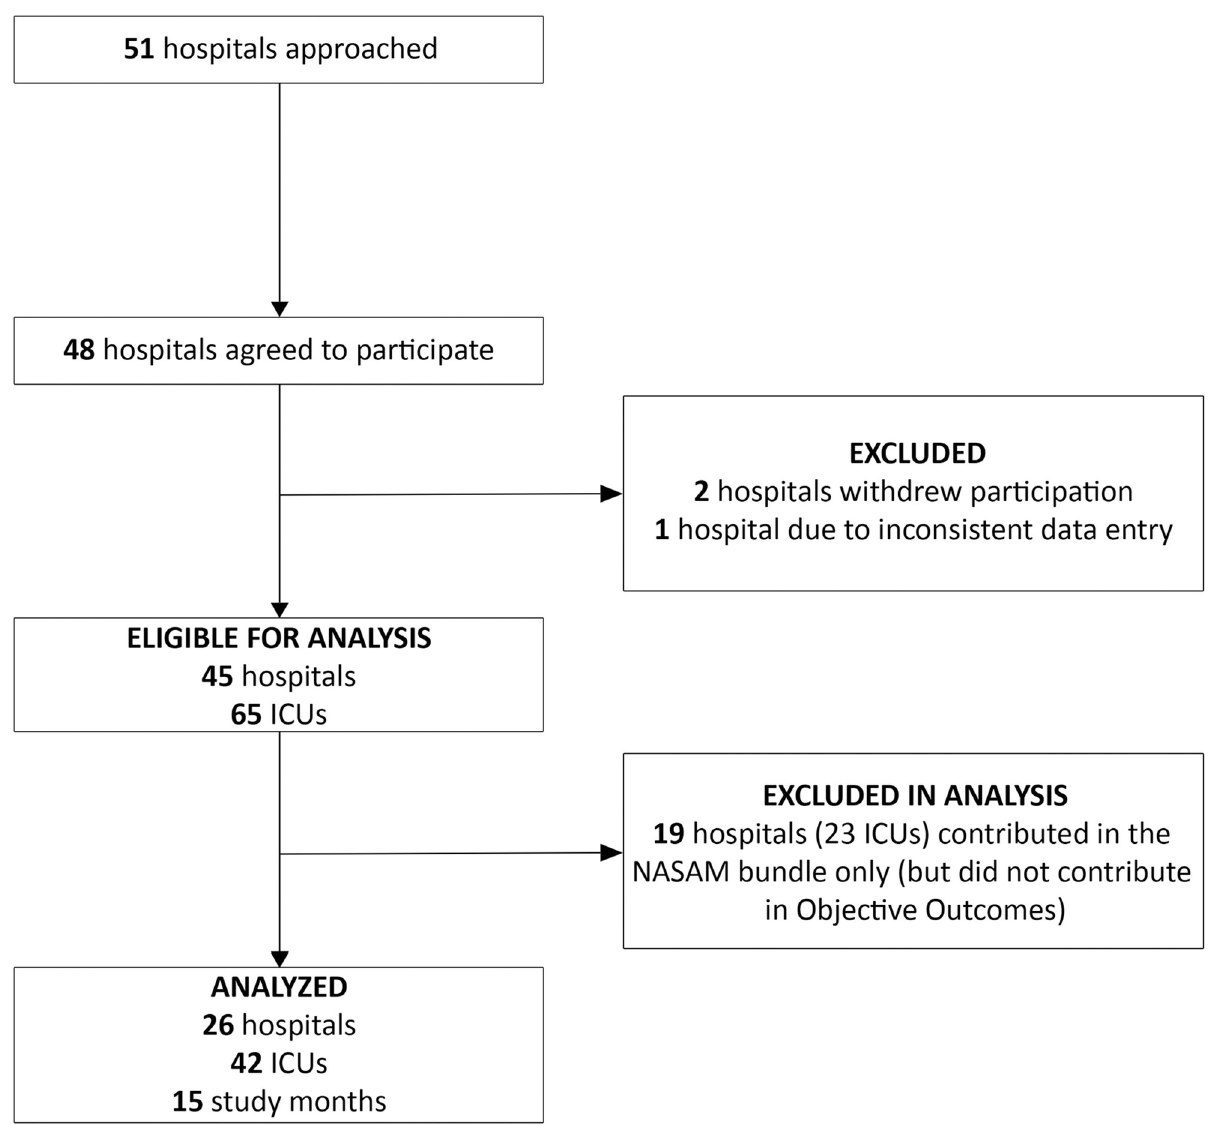
Fig 1. Study flow